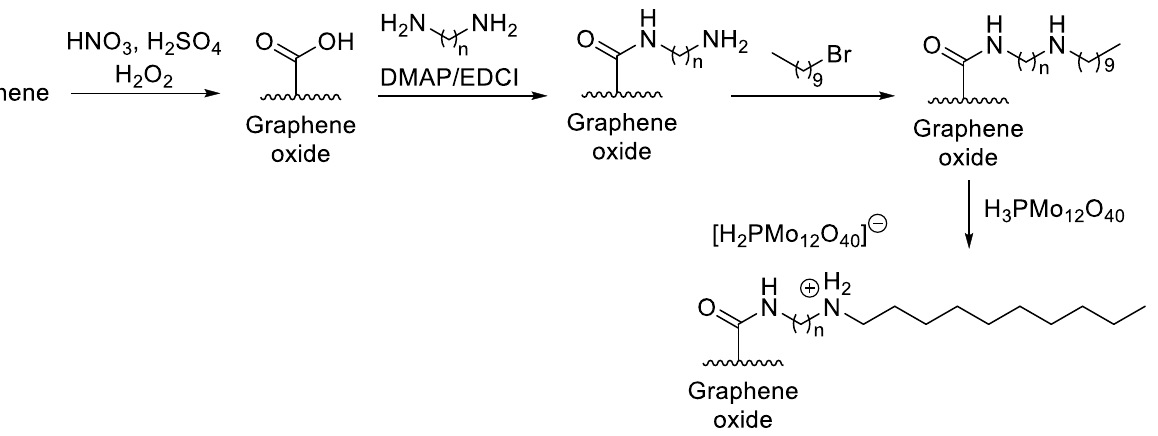
Scheme 12. Graphene catalyzed conversion of glycerol into lactic acid.